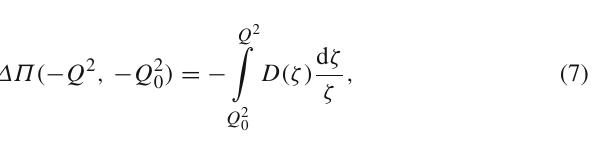
Fig. 1 The integration contour in Eq. (6). The physical cut ζ ≥ 4 m 2 π of the Adler function D ( − ζ) (4) is shown along the positive semiaxis of real ζ